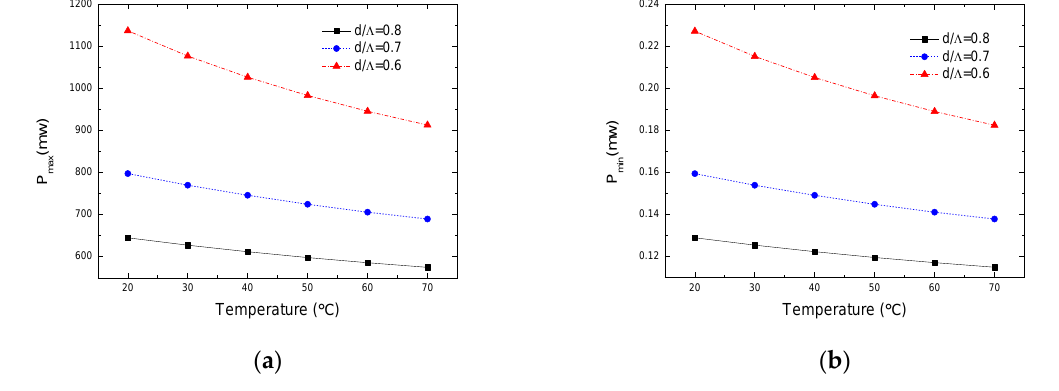
P P Figure 7. ( a ) max and ( b ) min vary with temperature. Figure 7. ( a ) P max and ( b ) P min vary with